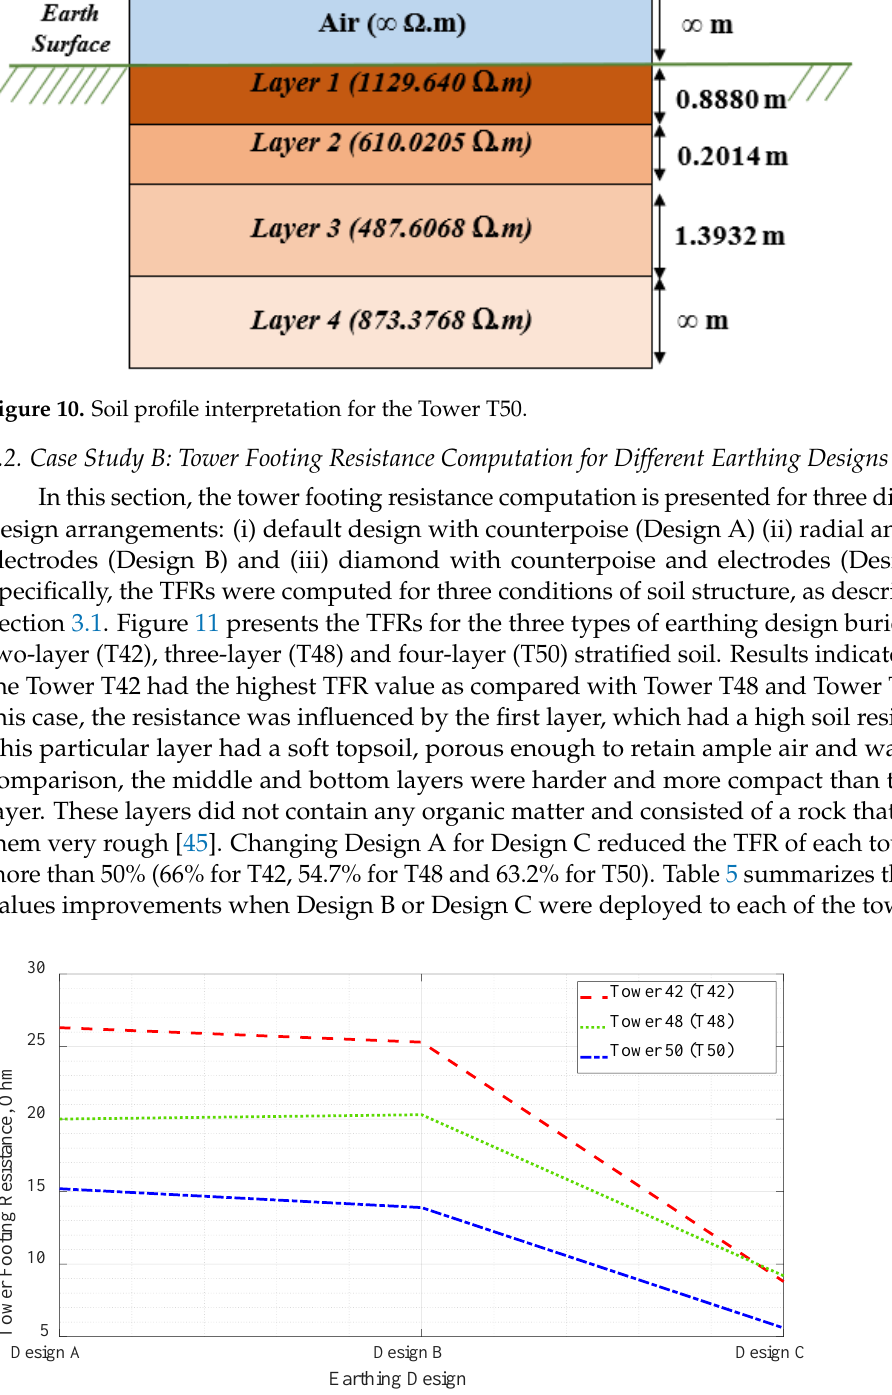
Figure 9. Soil profile interpretation for the Tower T48.